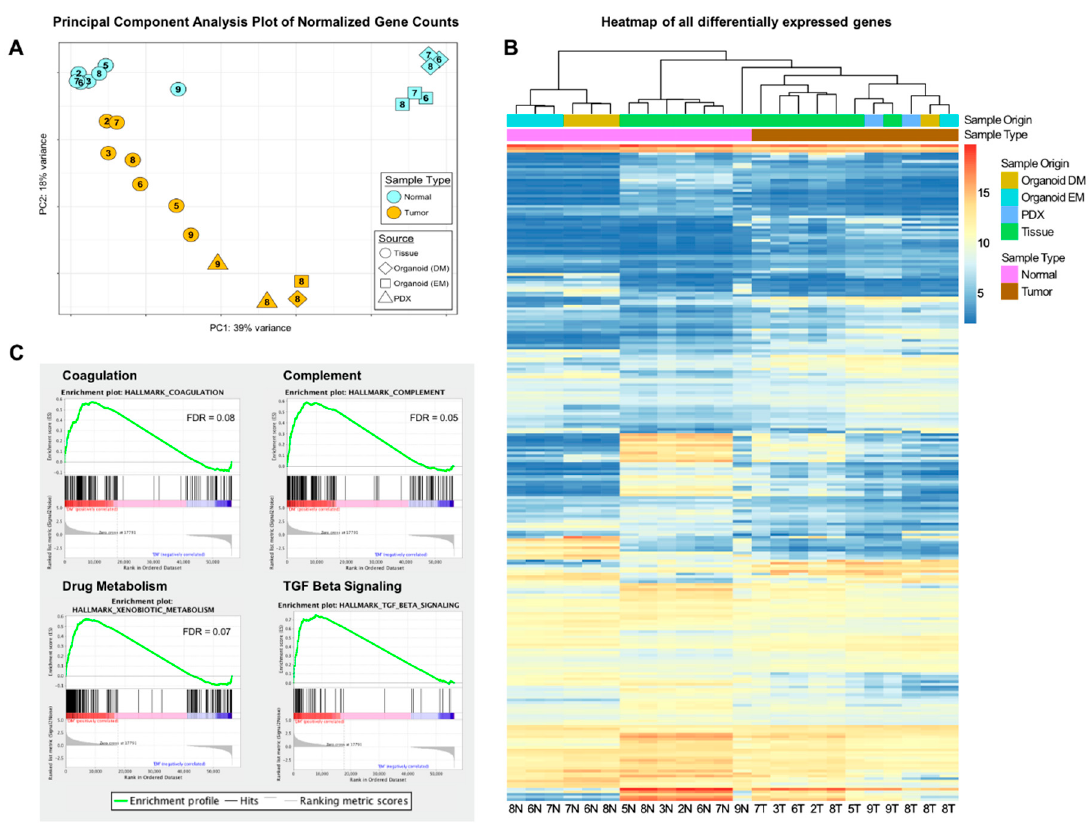
Figure 5. ( A ) Principal component analysis (PCA) plot of dimensions 1 and 2 (PC1 vs PC2) for RNAseq data (normalized counts per gene). The plot demonstrates similarity between normal tissue samples and a separation of normal organoids along PC1 and tumor samples along PC2. ( B ) Heatmap showing differentially expressed genes ( n = 3413) between hepatoblastoma tumor tissue samples and normal tissue samples. Individual genes are represented by rows, and samples are represented by columns. Columns are organized by unsupervised clustering. All normal samples cluster together as do